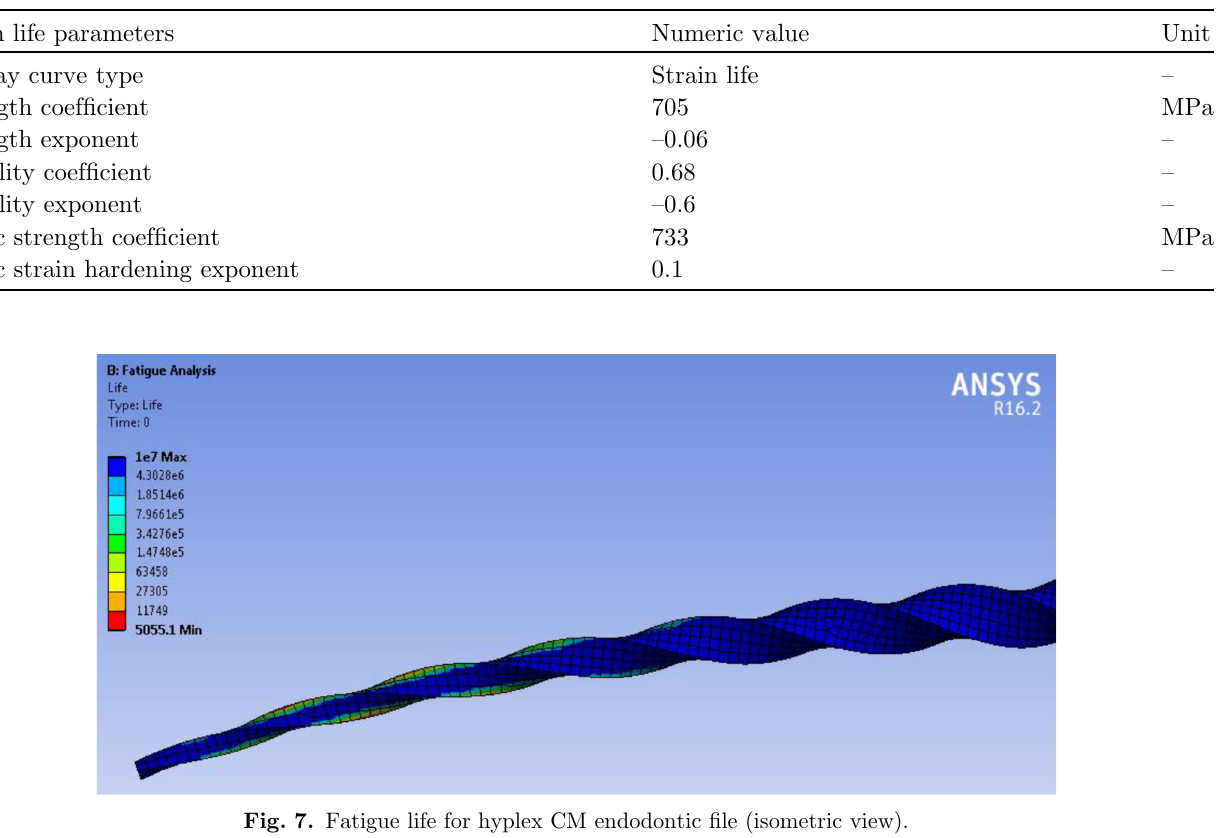
Table 3. Strain life parameters considered for the nickel-titanium fi le material.